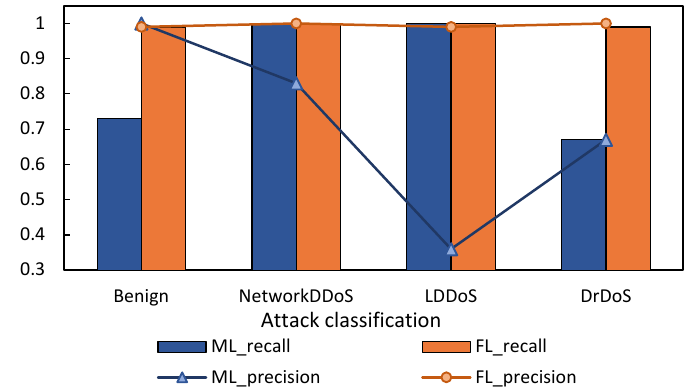
Figure 13. Comparison of FL and local ML without uploading datasets.